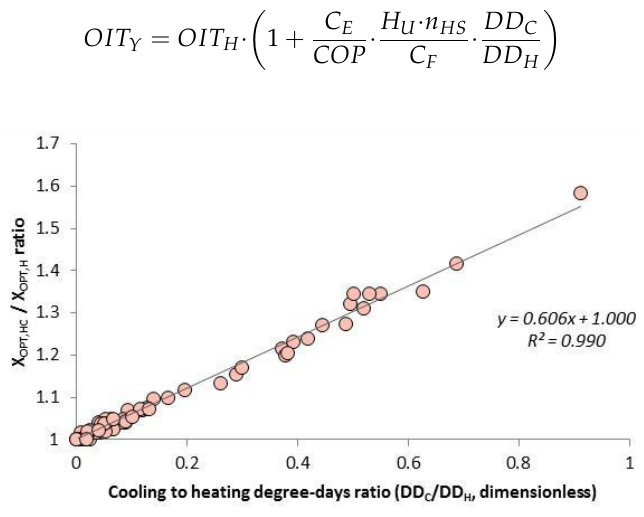
Figure 4. Effect of cooling degree-days to optimum insulation thickness (use of XPS insulating material and as a fuel the natural gas, data from [12]).